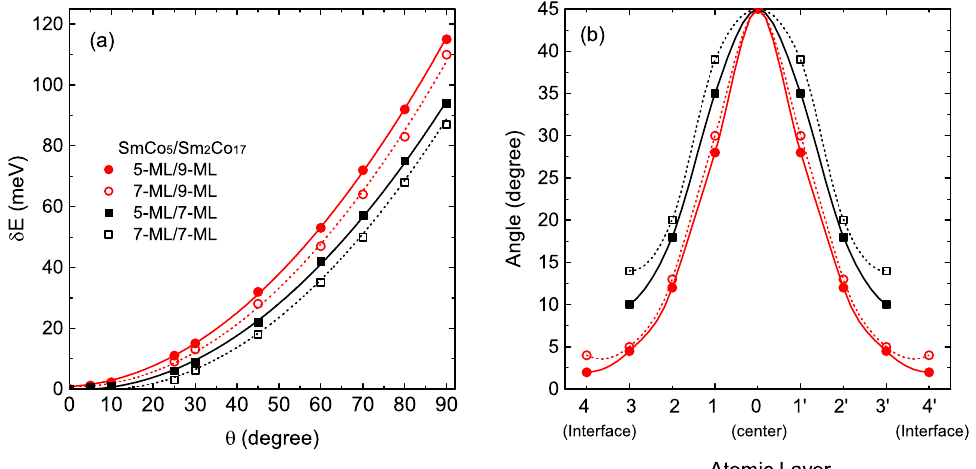
Figure 3. ( a ) The calculated total energy difference, δ E( θ ) = E( θ ) − E( θ = 0 ◦ ) and their fitting to a quadratic curve for the four systems with various atomic thickness; ( b ) The angle distributions for the soft phase atomic layers parallel to the interface plane (refer to Figure 1). 0 label represent centered layer which is the middle layer of the soft phase, whose atomic magnetic moments are turned at a fixed value of 45 ◦ away from those in the hard phase layers. All the atomic magnetic moment orientation in layers 1 (1 (cid:48) ), 2 (2 (cid:48) ), 3 (3 (cid:48) ), and 4 (4 (cid:48) ) are obtained